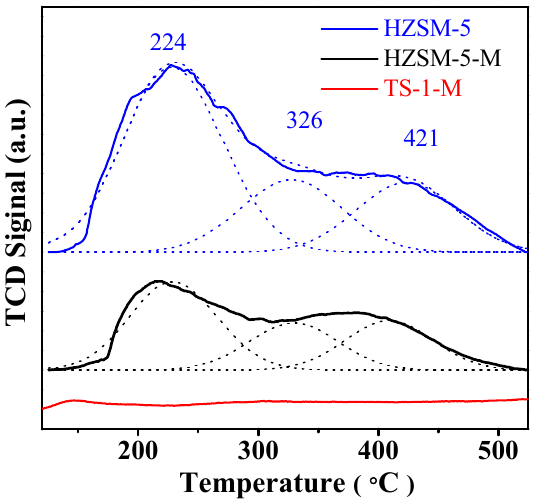
Figure 4. NH 3 -TPD curves and Gaussian deconvoluted peak of the samples.